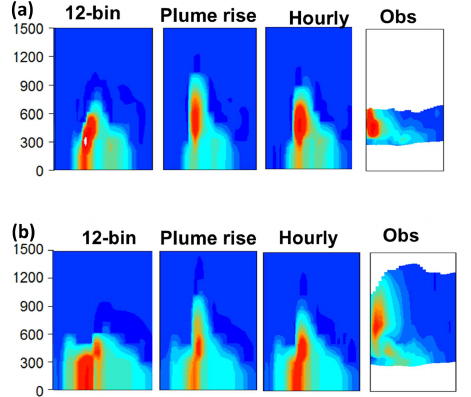
Figure 7. Zoomed-view of Fig. 5. (a) 17:42–17:54UTC: observa- tions interpolated from successive flight passes between 17:00 and 18:19UTC. (b) 19:08–19:20UTC: observations interpolated from successive flight passes between 18:42 and